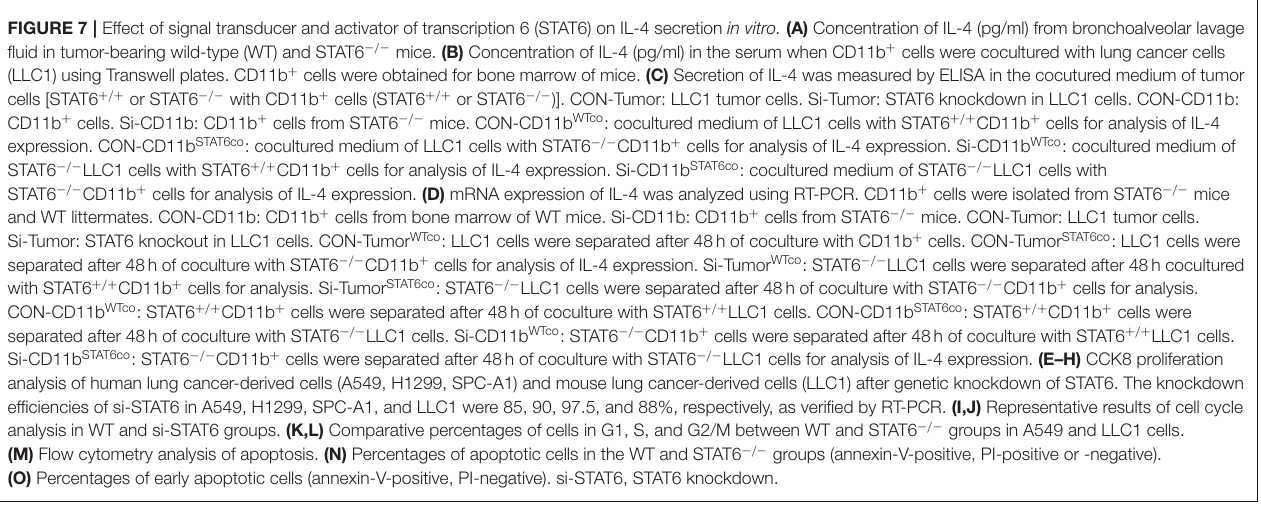
Frontiers in Immunology |